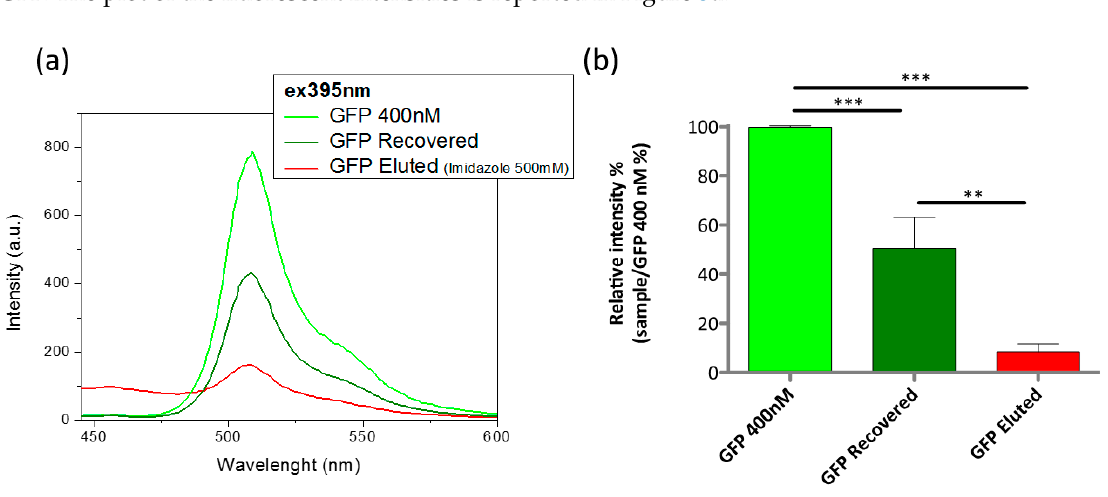
Figure 5. ( a ) Fluorescence emission spectra and relative intensity percentage of green fluorescent protein (GFP) solutions of solutions (excitation 395 nm, emission 508 nm) as quantitative estimation of the protein recovered after incubation (dark green curve) and eluted from the solid support (red curve) compared to the feeding solution of GFP (light green curve) ( b ). The quantitative values have been averaged over 3 measurements. Error bars represent standard deviation (SD) (*** p < 0.001, ** p < 0.01).